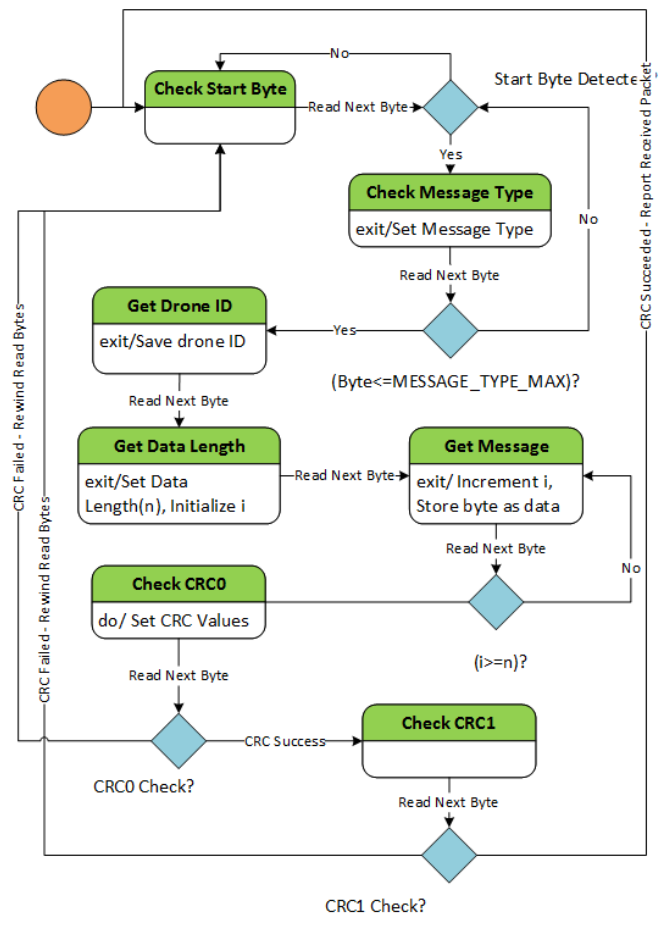
Figure 8. State diagram for packet